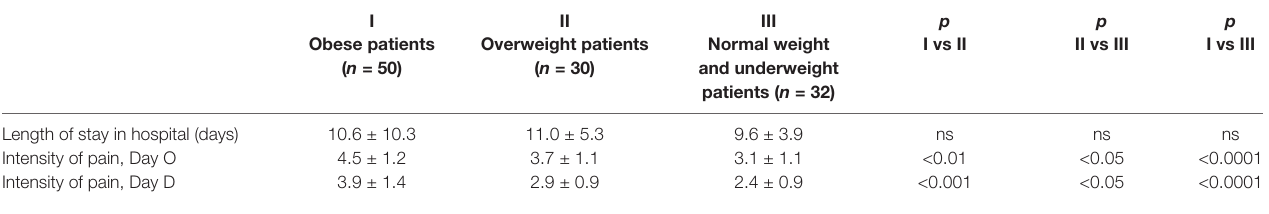
TABLE 3 | Comparison of the length of stay in hospital and the intensity of pain in surgically treated lung cancer patient groups of obese (I), overweight (II), and normal weight/underweight patients